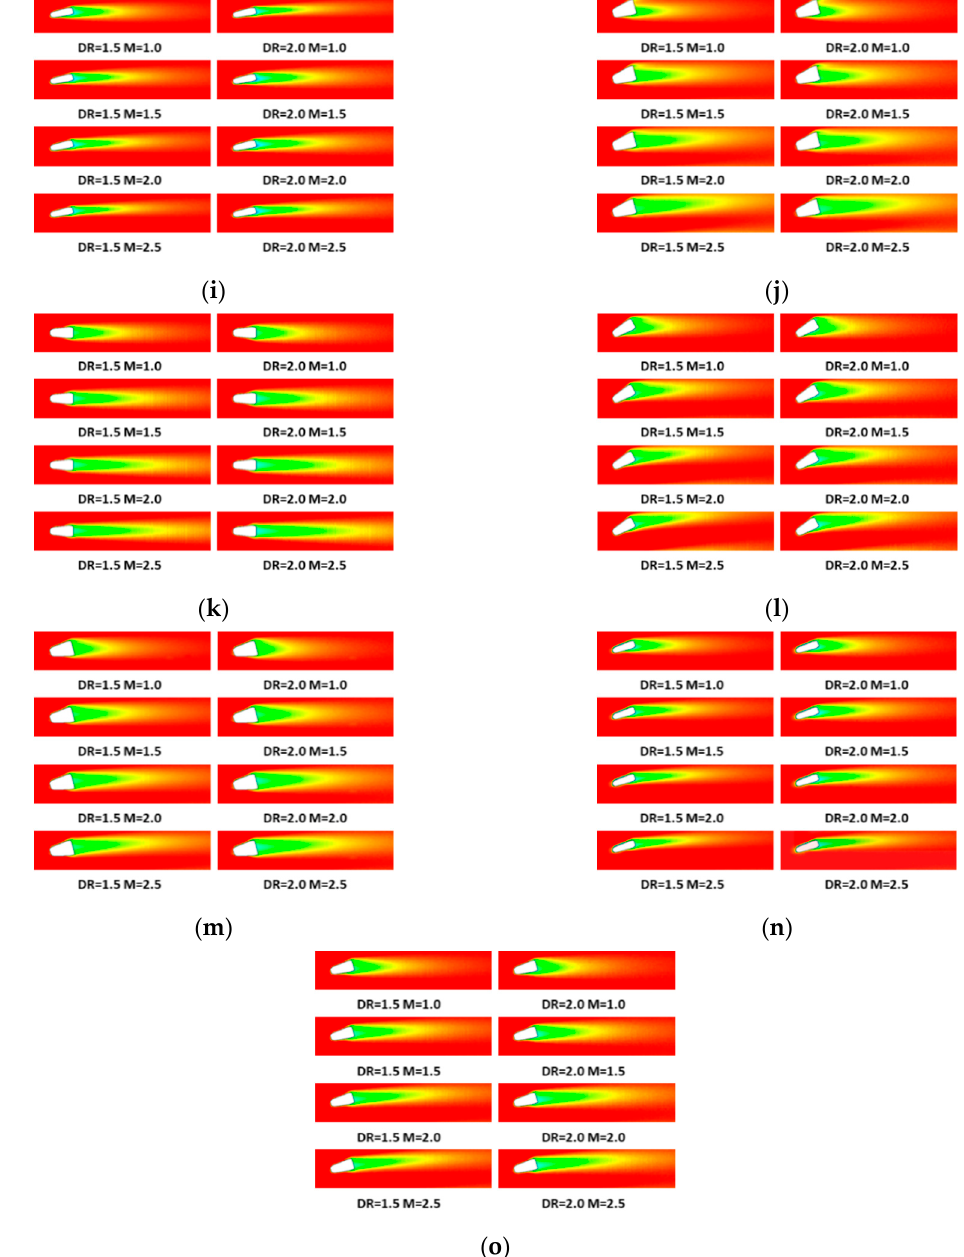
Figure 5. Distribution of the FCE: ( a ) Case 1 (11.96-11.96-6.08); ( b ) Case 2 (3.04-3.04-6.08); ( c ) Case 3 (3.04-11.96-6.08); ( d ) Case 4 (11.96-3.04-6.08); ( e ) Case 5(11.96-3.04-23.92); ( f ) Case 6 (11.96-11.96-23.92); ( g ) Case 7 (3.04-3.04-23.92); ( h ) Case 8 (3.04-11.96-23.92); ( i ) Case 9 (0-7.5-15); ( j ) Case 10 (15-7.5-15); ( k ) Case11 (7.5-7.5-0); ( l ) Case 12 (7.5-7.5-30); ( m ) Case 13 (7.5-15-15); ( n ) Case 14 (7.5-0-15); ( o ) Case 15 (7.5-7.5-15).